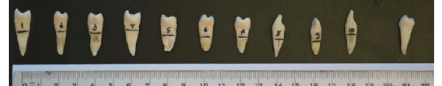
Figure 1: Sample selection of monoradicular teeth and control group after cleaning and disinfection.